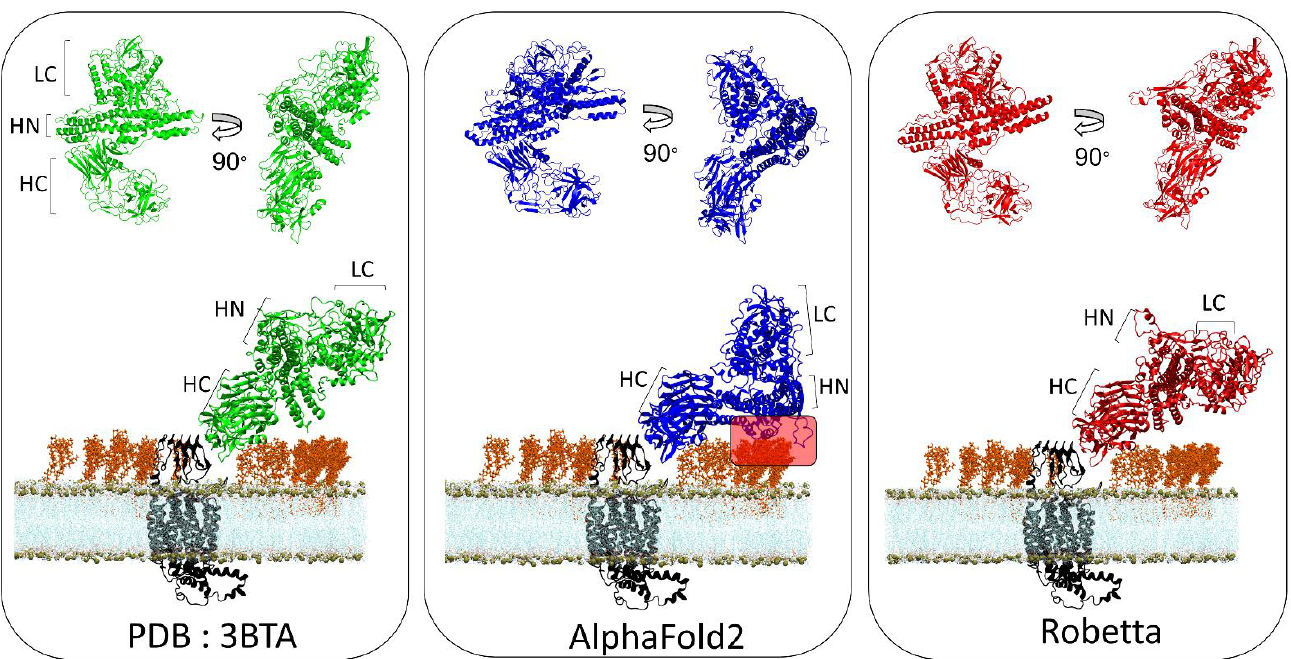
Figure 5. Structural comparison of the spatial organization of the domains of botulinum neurotoxin A obtained from Xray diffraction (PDB: 3BTA) ( left ), AlphaFold2 ( middle ) and Robetta ( right ) and molecular modeling of each structure with its membrane receptor human synaptic vesicle glycopro- tein C (h-SV2C) in a neural membrane context. The toxin receptor h-SV2C is depicted as a cartoon colored in black. The phosphate atom of each POPC lipid is shown as brown spheres. GT1b mole- cules are represented as orange sticks and the lipid tail of POPC molecules are shown as thin blue lines.